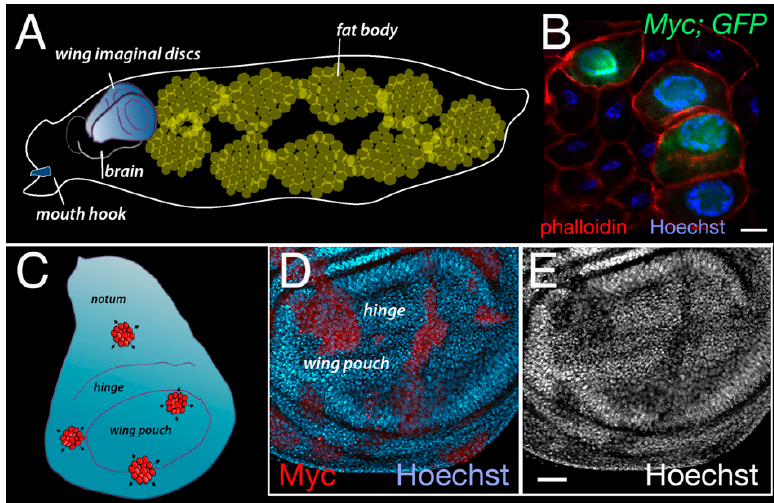
Figure 3. Expression of Myc increases nuclear size. ( A ) A schematic representation of a Drosophila larva indicating the position of the wing imaginal discs and of the fat body. ( B ) Photograph of cells from the fat body showing clones of cells overexpressing Myc generated using the flip-out UAS-Gal4 technique. This method allows the temporal induction of clones using the enzyme flippase under the control of the heat-shock promoter ( hsp70 ). The expression of the flippase is induced with a heat-shock at a specific time of the development to excise the FRT > sequences in the construct actin > CD2 > Gal4; UAS-HA-Myc; UAS-GFP . Gal4 is then produced under the control of the constitutive actin promoter, and binds the UAS sequences upstream of the myc cDNA allowing its expression. UAS-GFP is co-expressed and used as a marker for the clones [35] . Phalloidin (in red) labels the membranes, while nuclei are stained with Hoechst; scale bar 20 μ m. ( C ) A schematic representation of a Drosophila wing imaginal disc expressing clones induced using the flip-out technique. ( D , E ) Photographs of the pouch of a wing imaginal disc of a third instar larva, showing the presence of flip-out clones expressing Myc (in red). ( D ) Myc protein is visualized by immunostaining using an anti-HA antibody that binds to its tag at the N-terminus [36] . Nuclei are stained with Hoechst (green). ( E ) is the same wing disc as in D, only in black and white to better visualize the nuclei. Myc ability to induce endoreplication [27] results in cells having bigger nuclei, which appear sparse in the photo due to their increase in size compared to nuclei in wild type cells; scale bar 50 μ m.